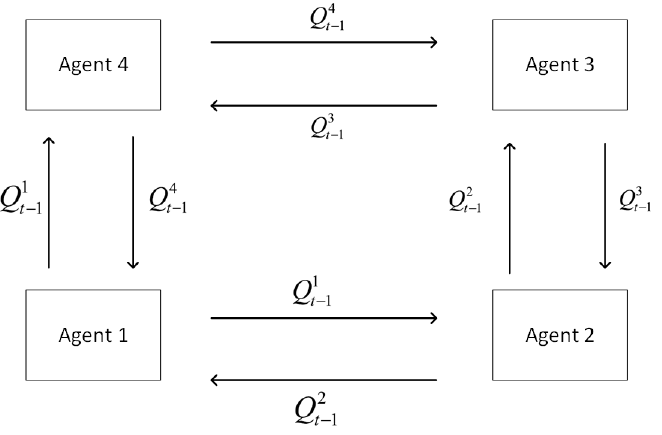
Figure 6. Architecture of cooperative